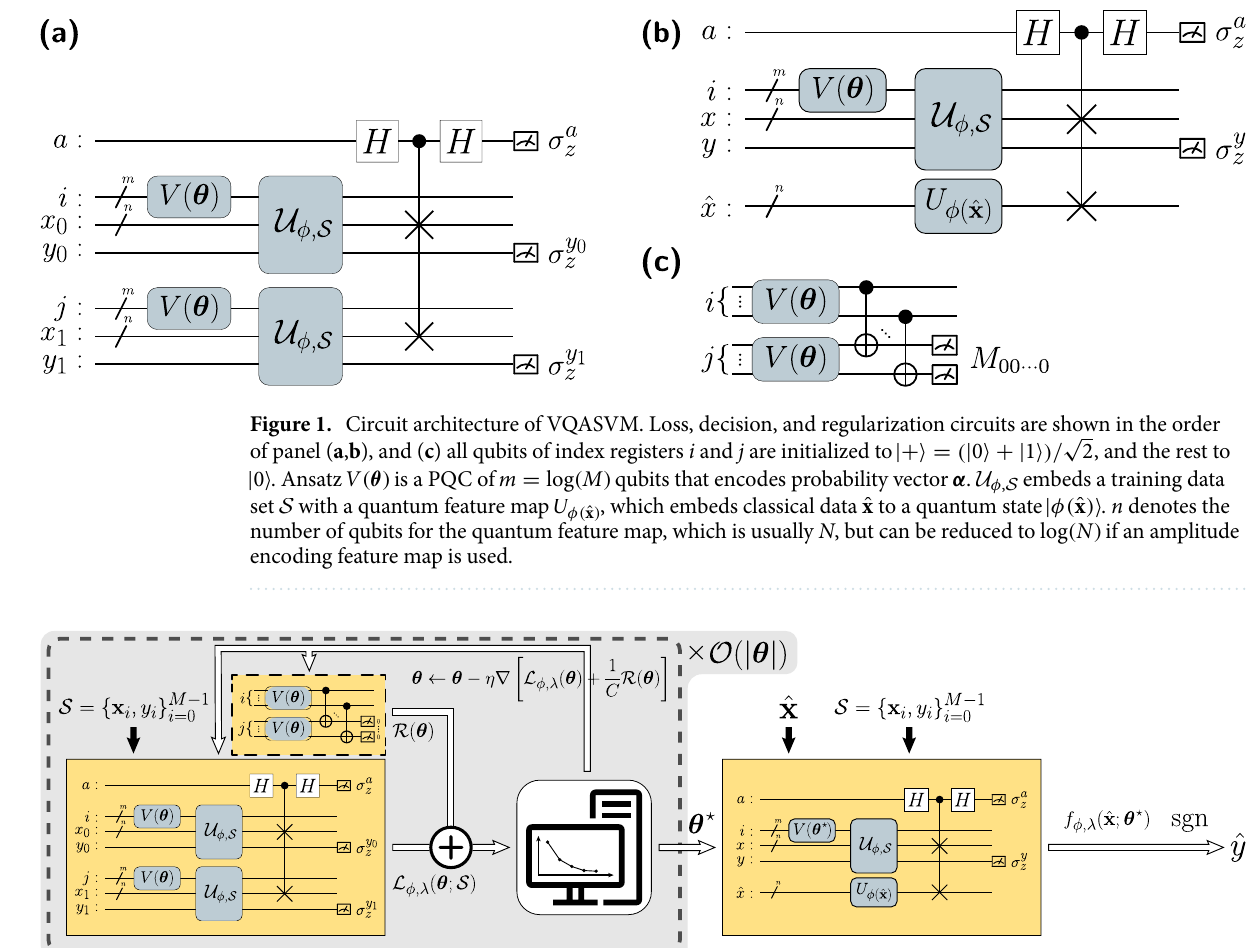
Figure 2. Variational quantum approximated support vector machine. The white round boxes represent classical calculations whereas the yellow round boxes represent quantum operations. The white arrows represent the flow of classical data whereas the black arrows represent the embedding of classical data. The grey areas indicate the corresponding training phase of each iteration. The regularization circuit in the black dashed box can be omitted for a hard-margin case where C → ∞